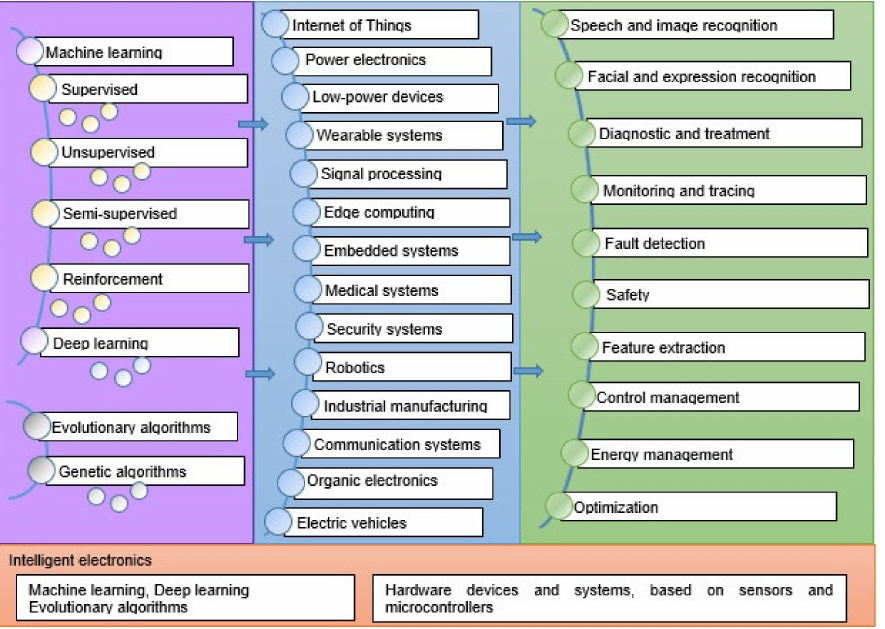
Figure 13. Conceptual framework about utilization of machine learning in